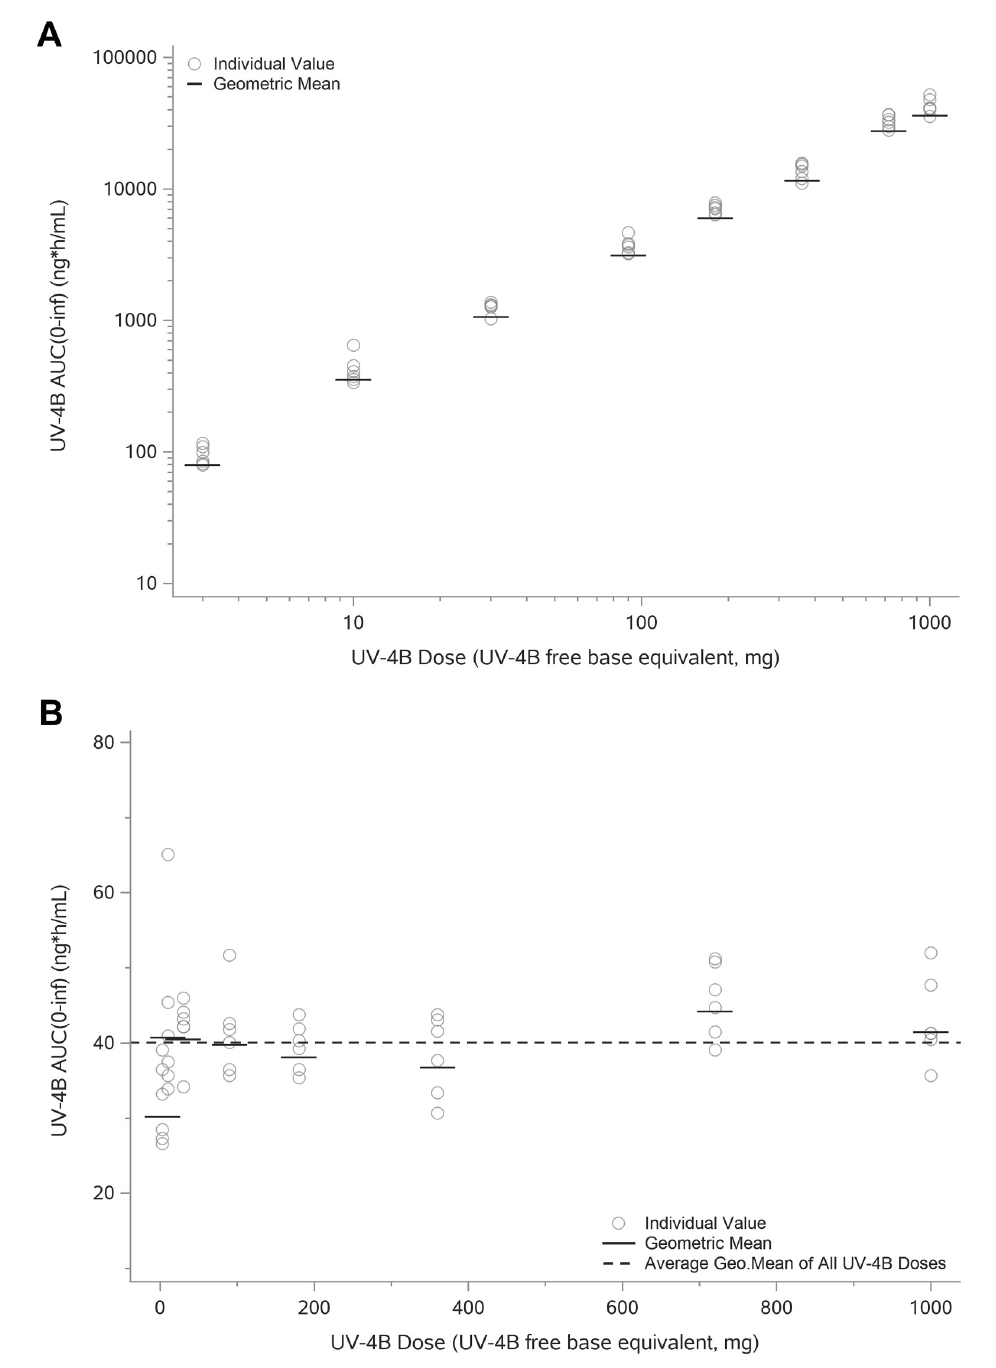
Fig 6. Individual and Geometric Mean AUC (0-inf) versus Administered Dose. A . Individual and geometric mean of AUC (0-inf) represented using log-scale. Overall AUC (0-inf) appears to increase in a generally dose proportional manner. B . Individual and geometric mean Dose Normalized AUC (0-inf) (DNAUC (0-inf) ) (linear scale). AUC (0-inf) increased in a dose- proportional manner over the 3 to 1000 mg (333-fold) UV-4 dose range. Mean‘and individual range of DNAUC (0-inf) of 3 mg group was slightly lower compared to the subsequent dose levels (10 to 1000 mg), for which the individual range and mean DNAUC (0-inf) values were similar. Dose proportionality was assessed utilizing a power model. The slope was 1.033 when dose proportionality was assessed over the 333-fold dose range, but the 90% CI estimates (1.013, 1.053) were not fully contained within the pre-specified confidence bounds (0.96, 1.04). When the dose proportionality assessment was repeated over